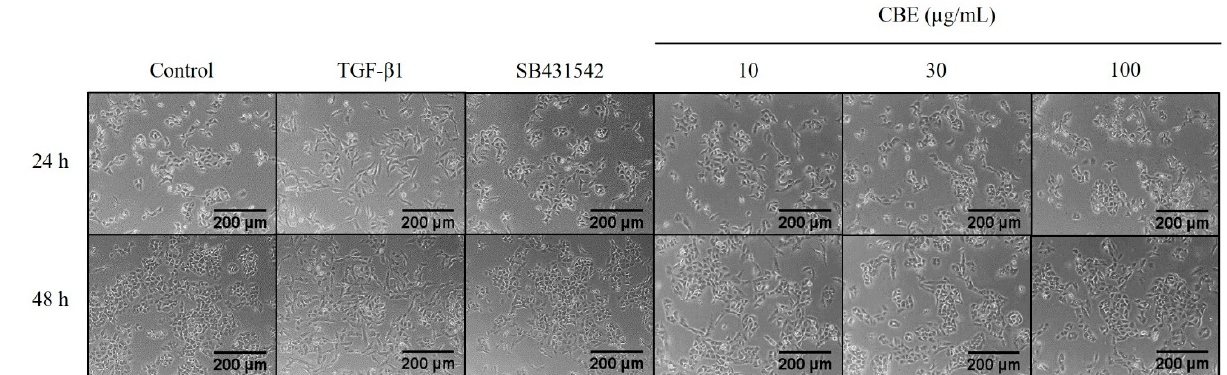
Figure 3. Effect of CBE on reversion of TGF- β 1-induced morphological changes in LoVo cells. Cells were pre-treated with CBE and SB431542. After incubation, cells were treated with TGF- β 1 for 24 and 48 h. Cell morphology was observed under a microscope. CBE, Cinnamomum bejolghota extract.